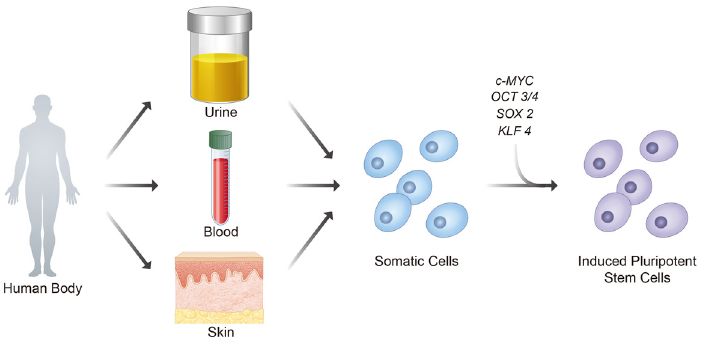
Figure 2. Key steps in generating iPSCs from the human samples. iPSCs can be formed by transducing OSKM factors into somatic cells derived from various locations. Notably, urine, blood, and skin are the most common samples used to collect somatic cells.